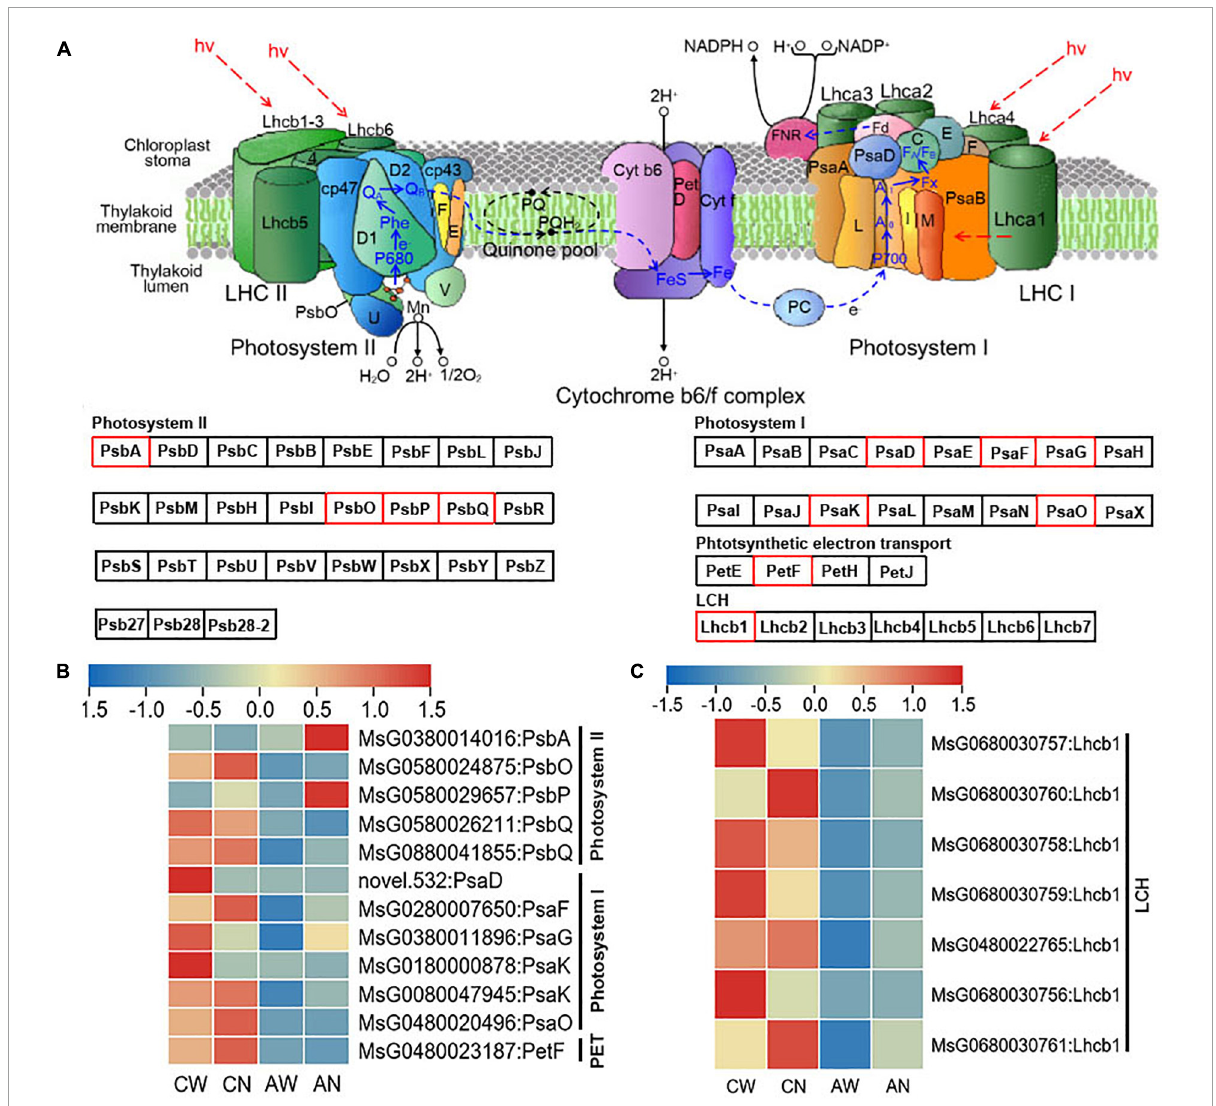
FIGURE6 (A) Differentially expressed genes involved in photosystem (PSI and PSII), photosynthetic electron transport (PET) process and light harvesting complex (LHC). DEGs are marked in red box. (B) Heatmap of DEGs annotated in PET, PSI and PSII according to transcriptome of WT